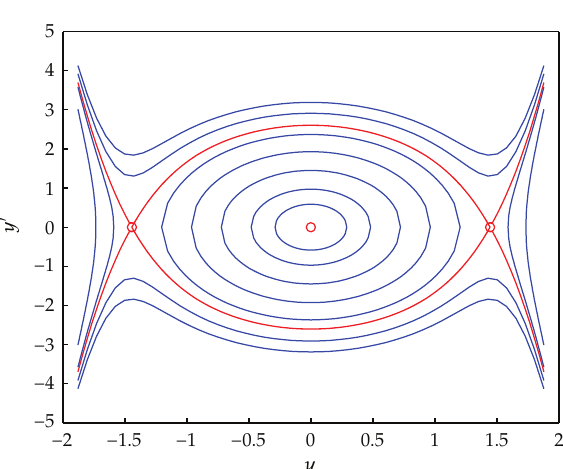
Figure 1: Phase portrait of critical equation (cid:2) 4.16 (cid:5) , where s α (cid:6)